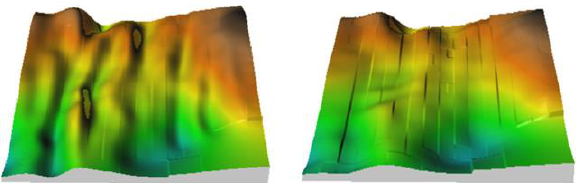
Figure 8. GPS data elevation models. Left image is tension 40 smoothing 0 and without anisotropy angle and scale factor. Right image is tension 40 smoothing 0, 25 degree anisotropy angle and 0.25 scale factor.